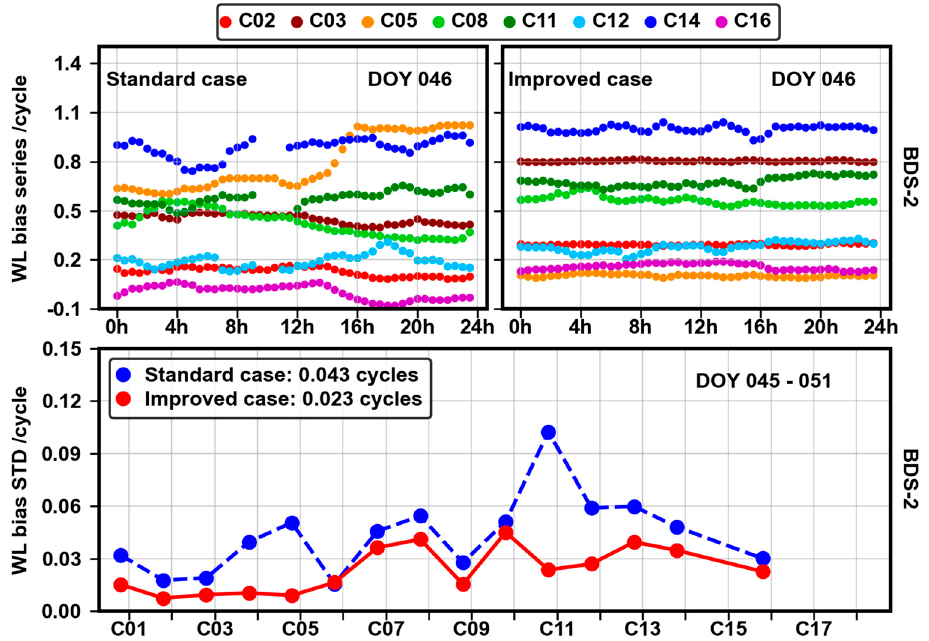
Figure 12. WL phase bias series on DOY 46, 2021 and the corresponding STDs across 7 days for BDS-2 for the standard case and improved case for the Case 4 network.